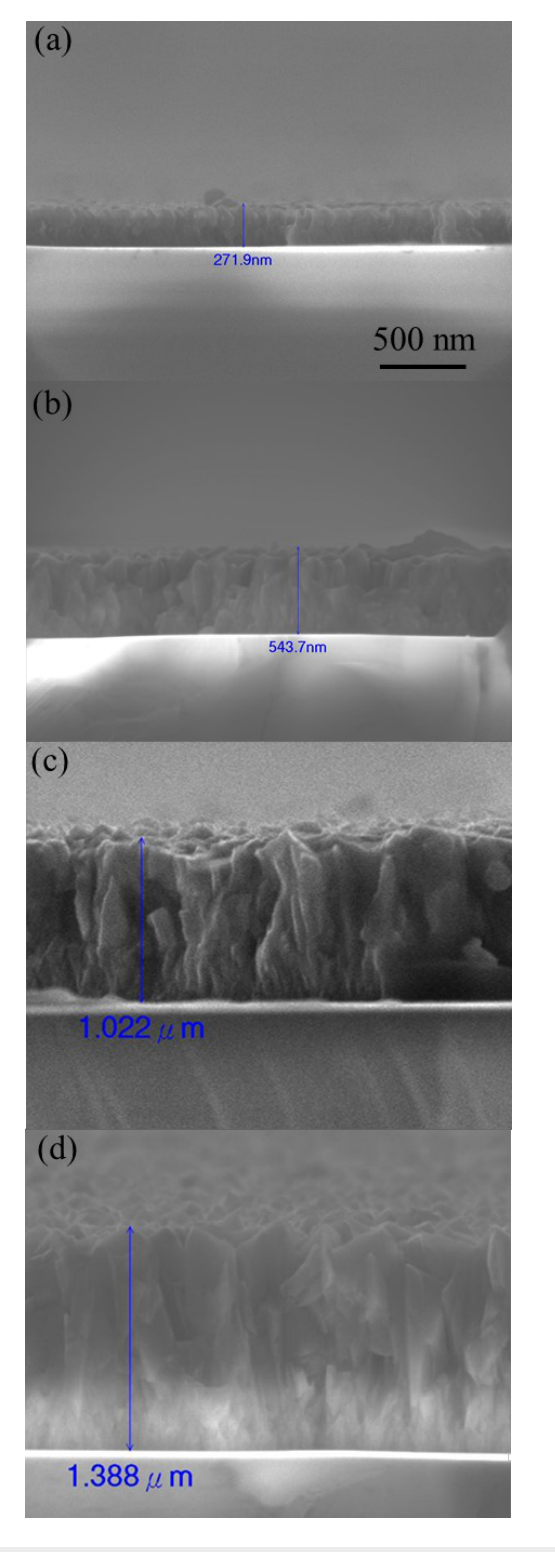
Figure 3: Cross-sectional SEM images of the (a) c -20, (b) c -40, (c) c -60, and (d) c -70 ZnO@B samples. The thickness of each sample is shown in the